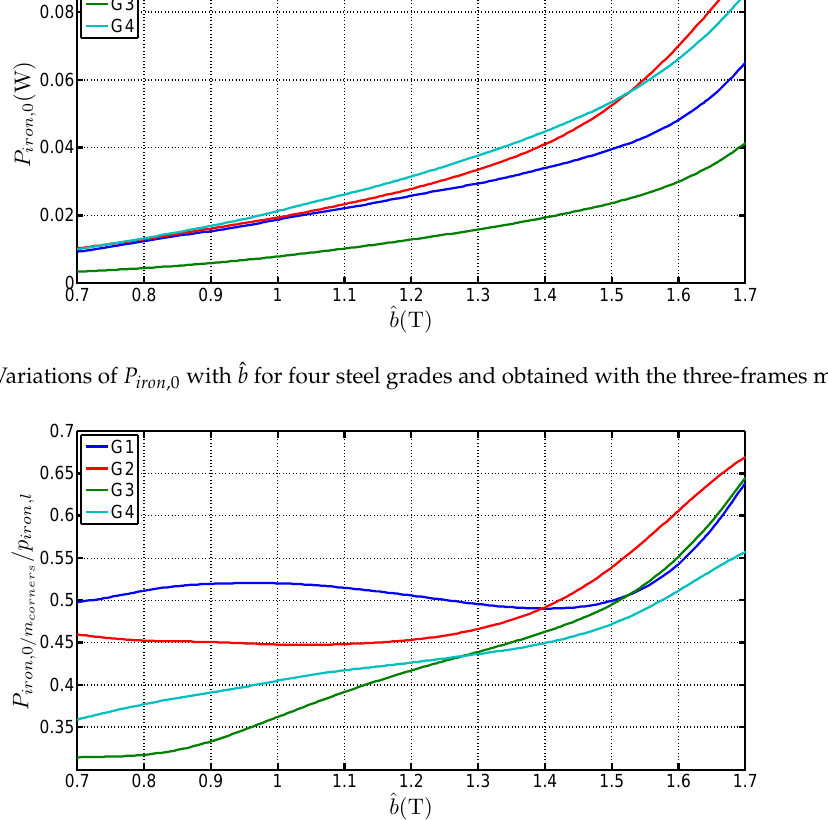
Figure 10. Variations of the ratio between the specific losses in the corners and in the limbs with ˆ b for 4 steel